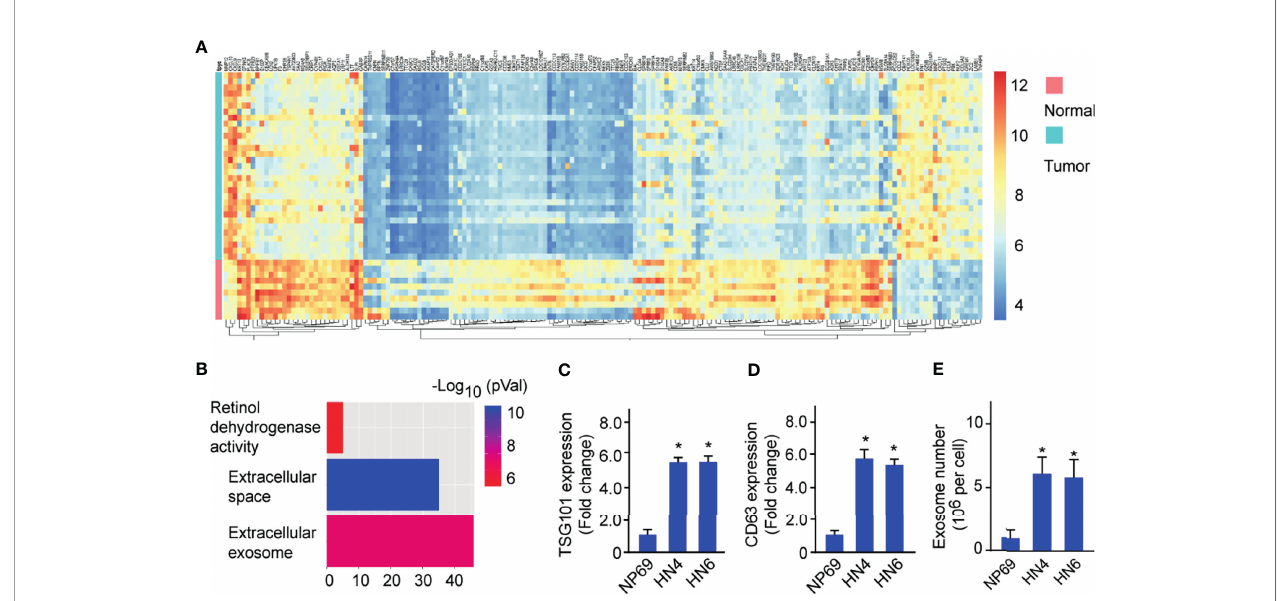
FIGURE 1 | Exosome biogenesis is upregulated in HNSCC. (A) Heatmap shows the expression pro fi le of differentially expressed genes between HNSCC tumor tissues and Normal tissues. (B) Enrichment pathway analysis was performed to analyze the dysregulated pathways. (C, D) TSG101 and CD63 mRNA expression in HN4, HN6, and NP69. (E) The exosome number in NP69 and HNSCC cell lines HN4 and HN6. All experiments were replicated in triplicate. * p < 0.05.